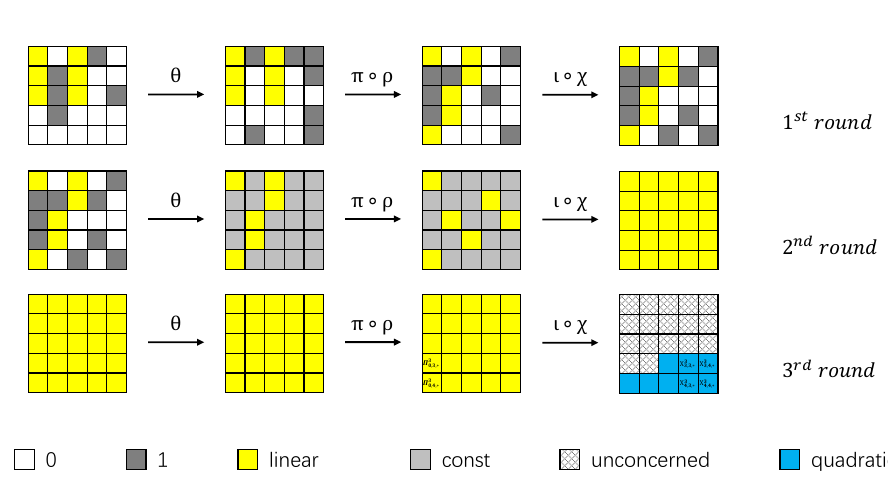
Figure 6: The 2.5-round linear structure for 3-round Keccak-256.